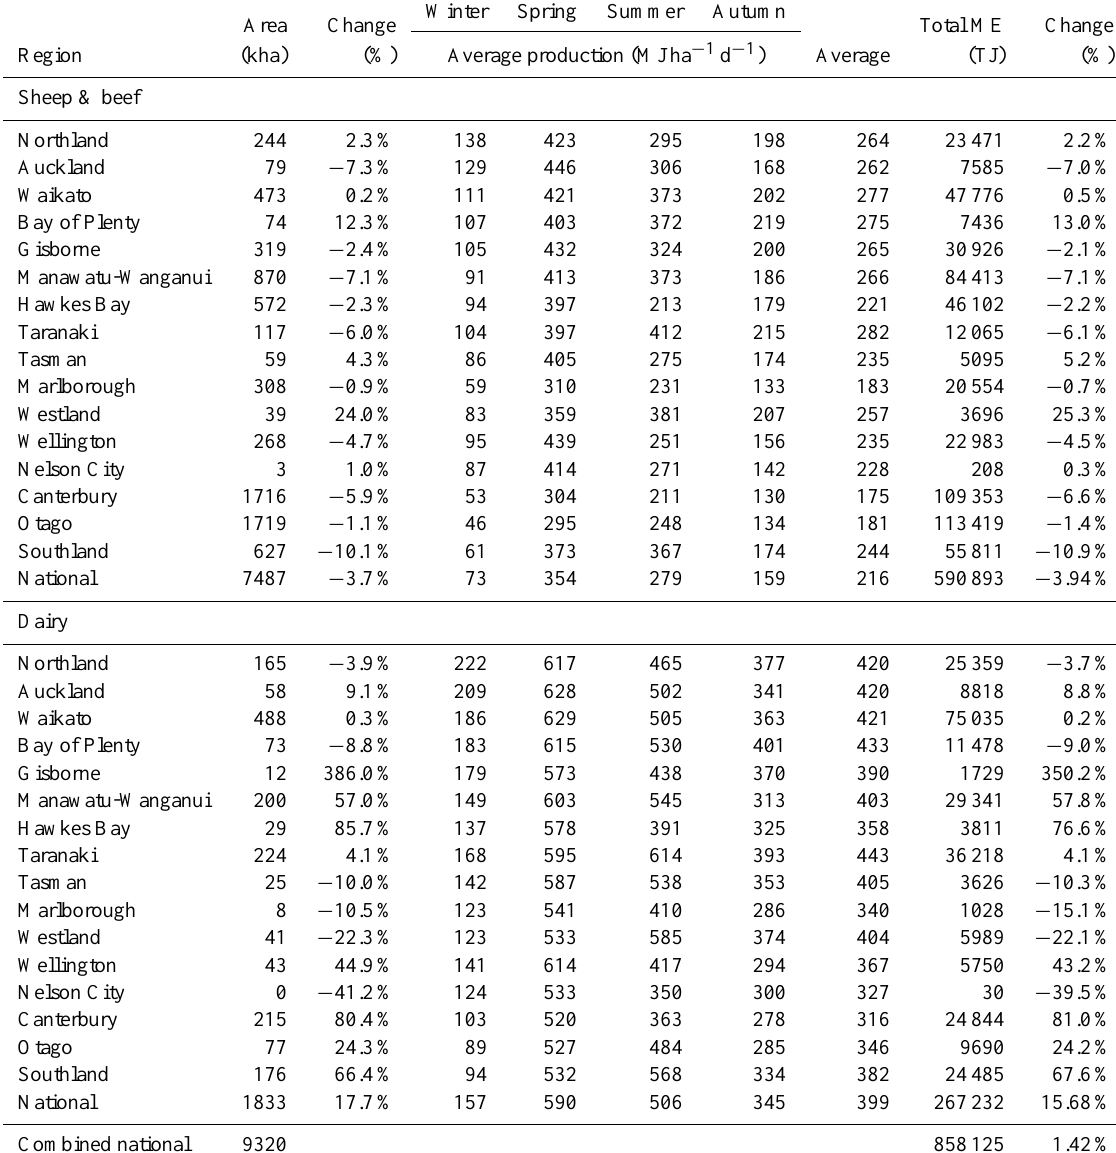
Total ME Change